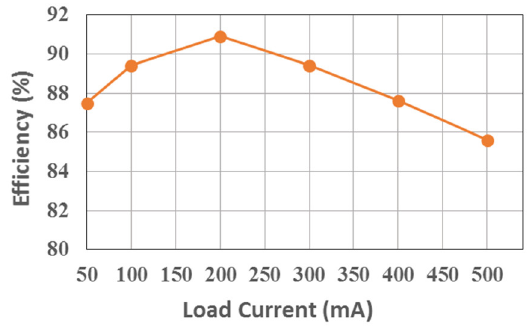
Figure 17. Efficiency versus different load currents. Table 1. Comparison of reported on-time controlled buck converters.